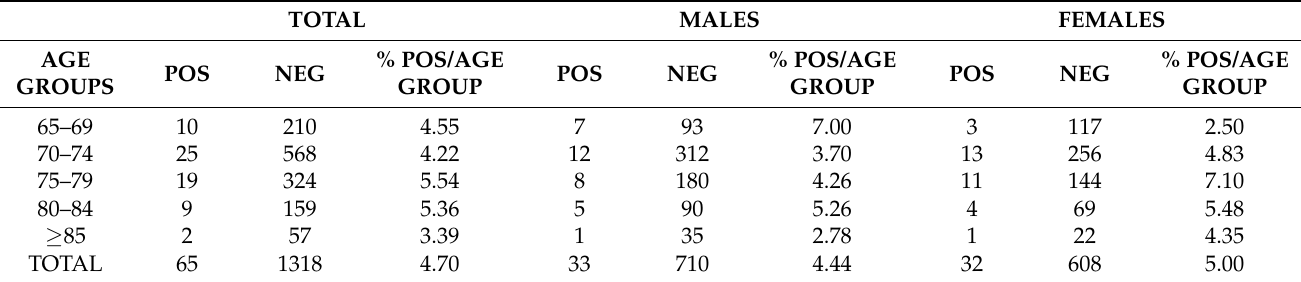
Figure 1. ( a ) Exact binomial distribution and 95% confidence intervals were determined by using the estimated prevalence of antibodies directed towards SARS-CoV-2 antigens calculated on all volunteers (upper panel), male volunteers (middle panel), female volunteers (lower panel). ( b ) Bar charts representative of anti-SARS-CoV-2 seroprevalence on total, male and female volunteers (upper panel) and distribution of IgG,- IgM- and IgG/IgM-positive among total, male and female seropositives (lower panel). Table 2. Distribution of SARS-CoV-2 antibody-positive samples by age groups